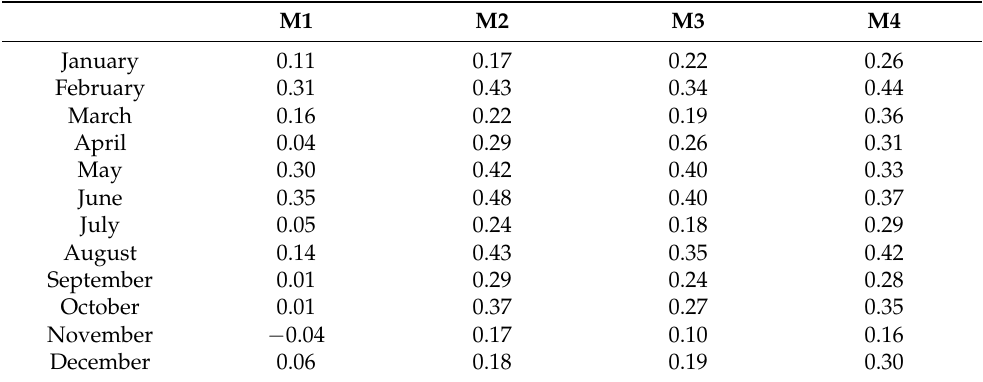
Table 6. Values of the Pearson r correlation coefficient between the value of the volume of electricity consumed and horizontal insolation in the individual months in 4 analyzed cases of mines.